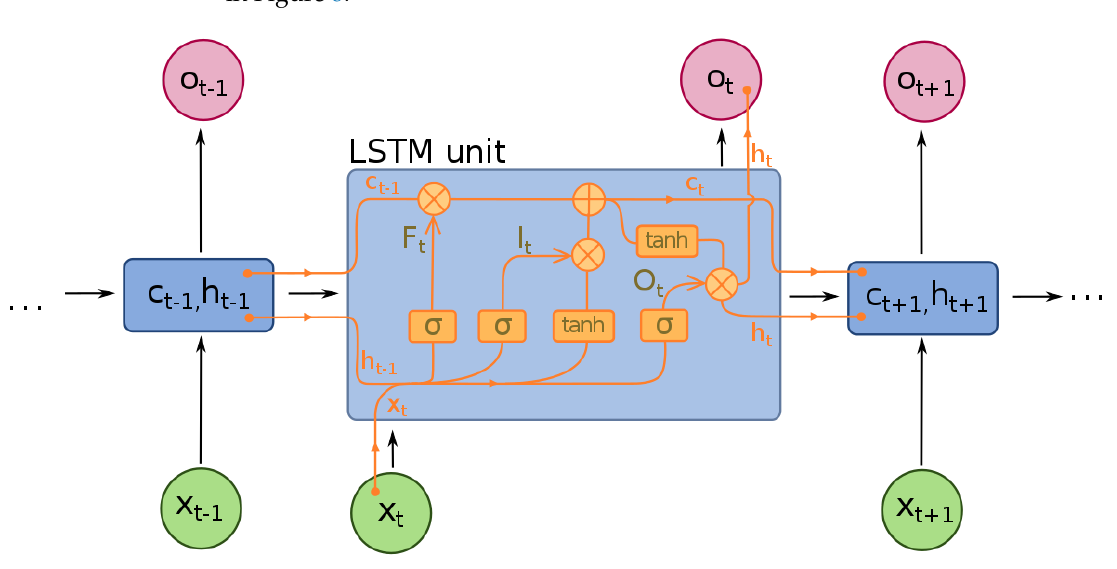
Figure 7. A 5 × 5 filter rolling around an input volume and generating an output.